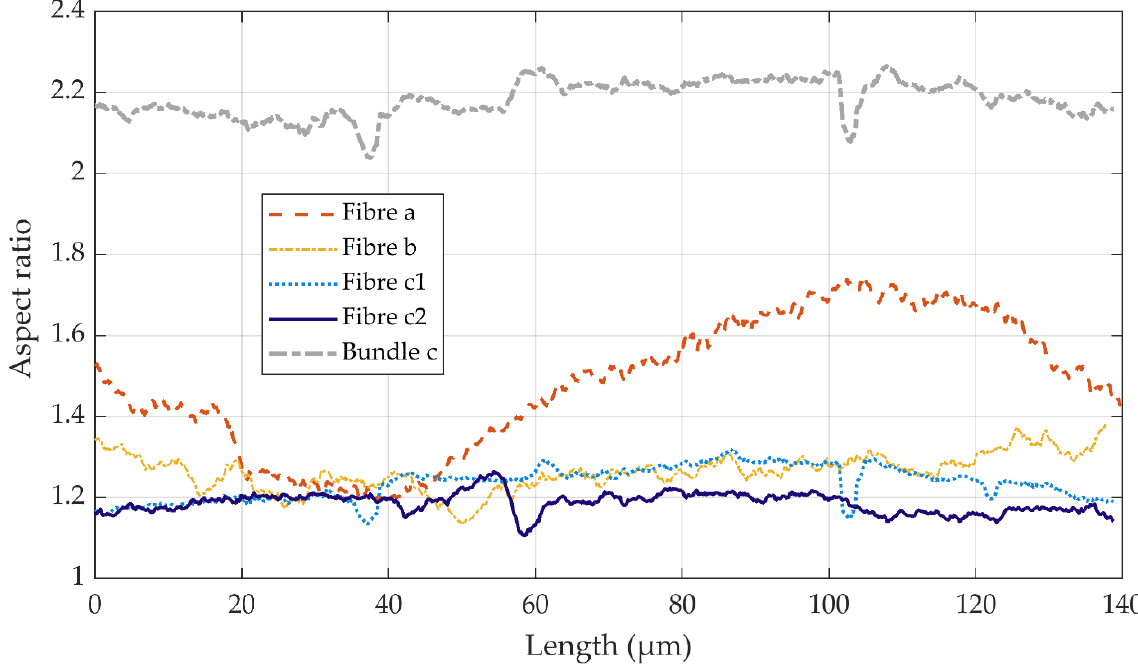
Figure 9. Evolution of the aspect ratio along two flax fibres “a” and “b” and a bundle “c” composed of two fibres “c1” and “c2”, measured from X-ray microtomography data .